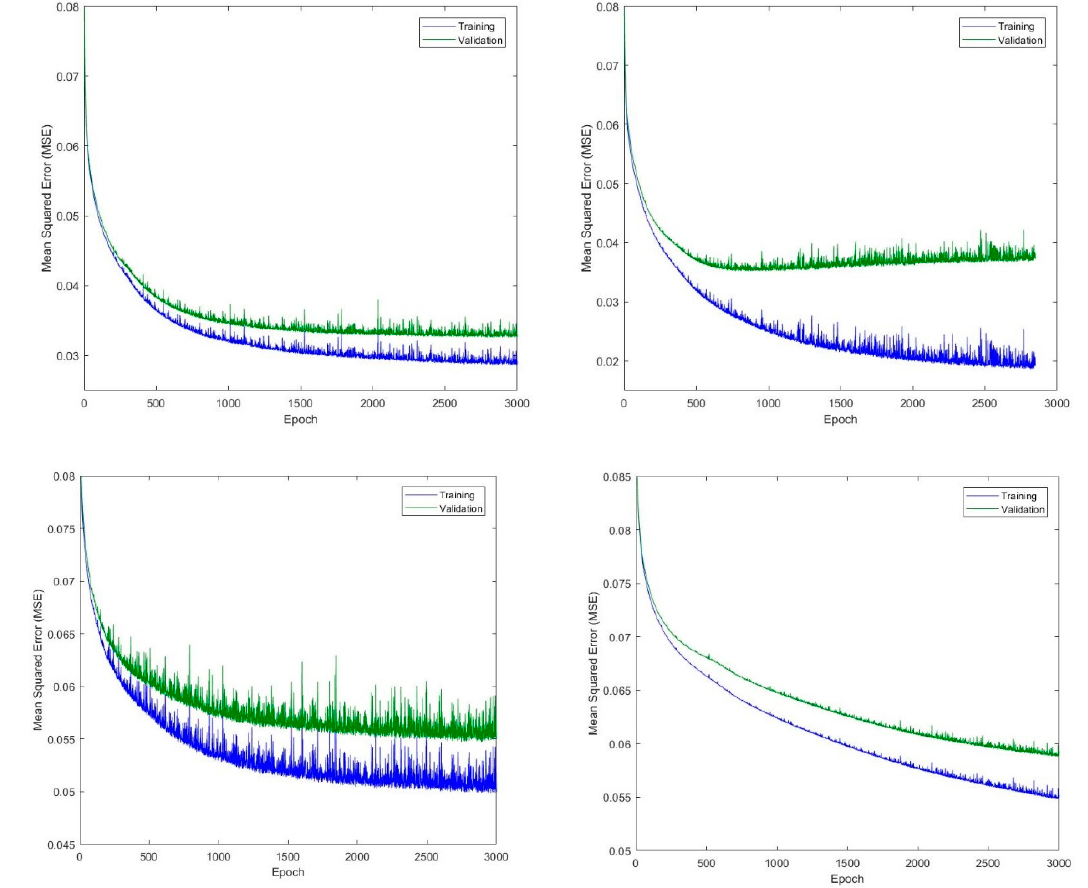
Figure 6. The learning curve of the model.